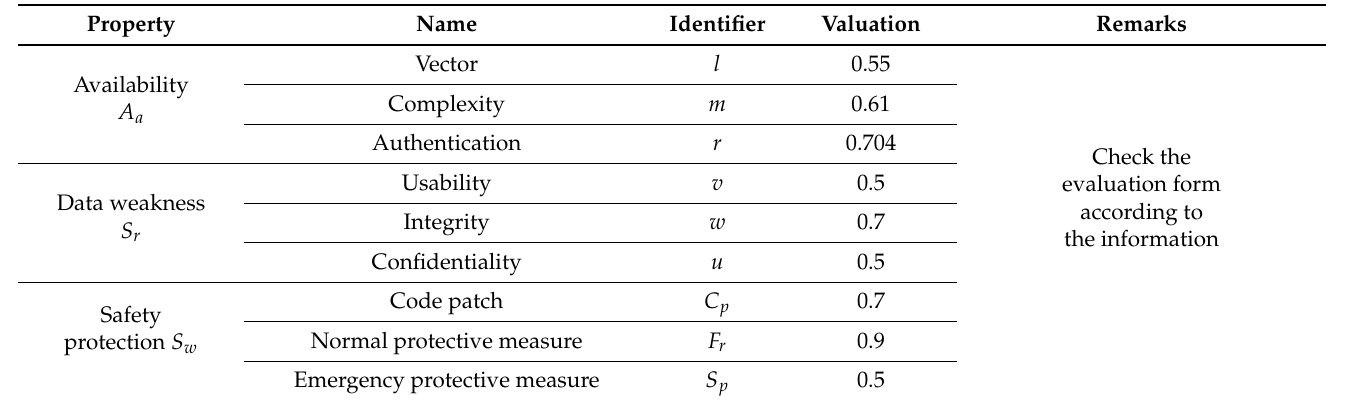
Table 9. Control system information sheet.